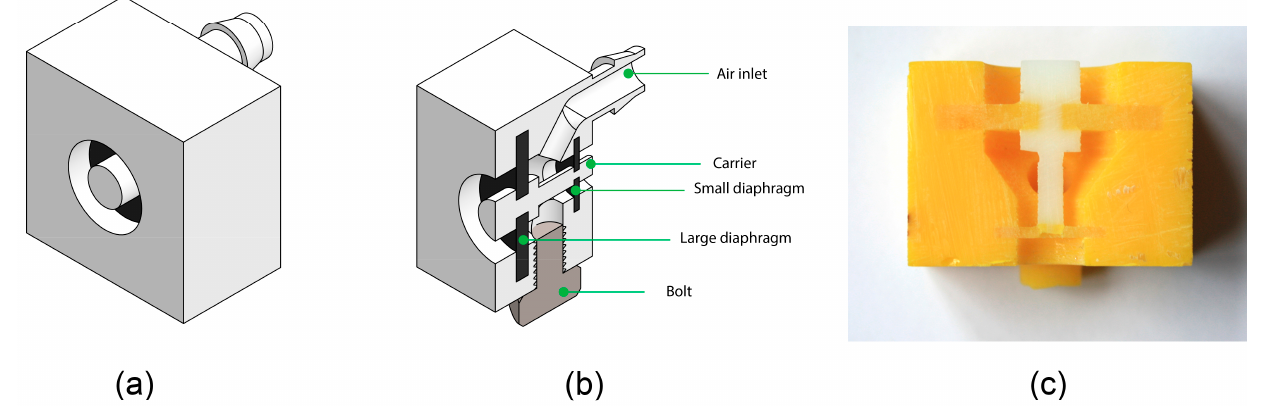
Figure 7. Prototypes of the dual diaphragm mechanism used for the experimental evaluation. ( a ) 3D model of the prototype. ( b ) Cross-section of the 3D model showing the various parts. ( c ) Cross-section of the 3D printed prototype.